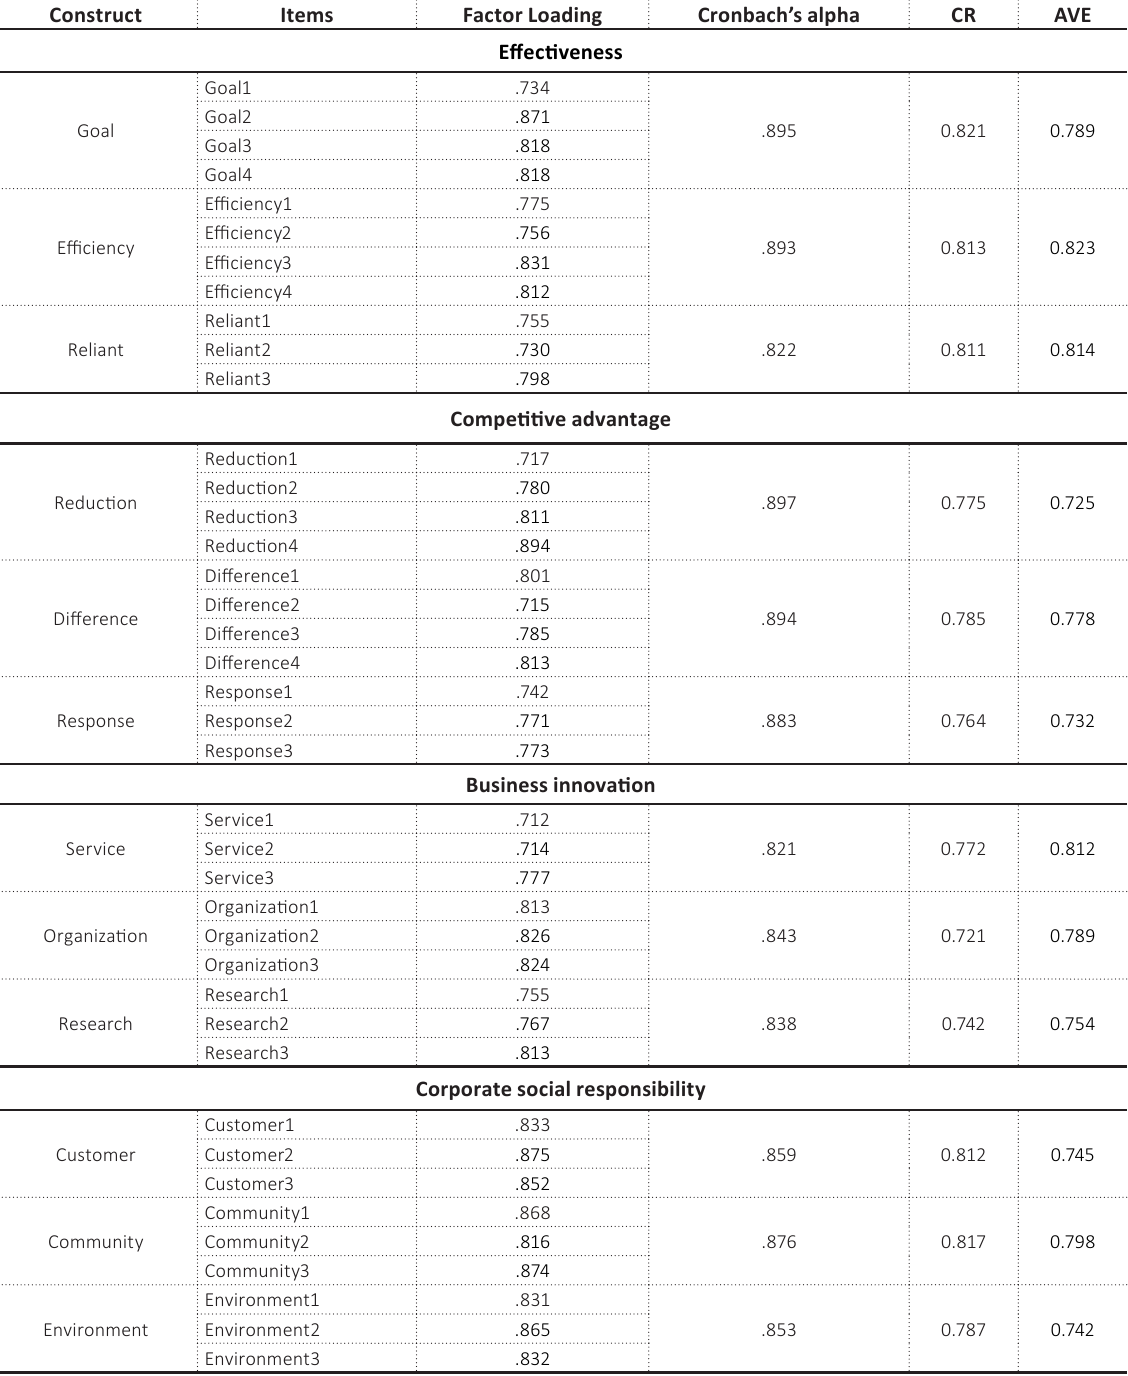
Table 2. Measurement